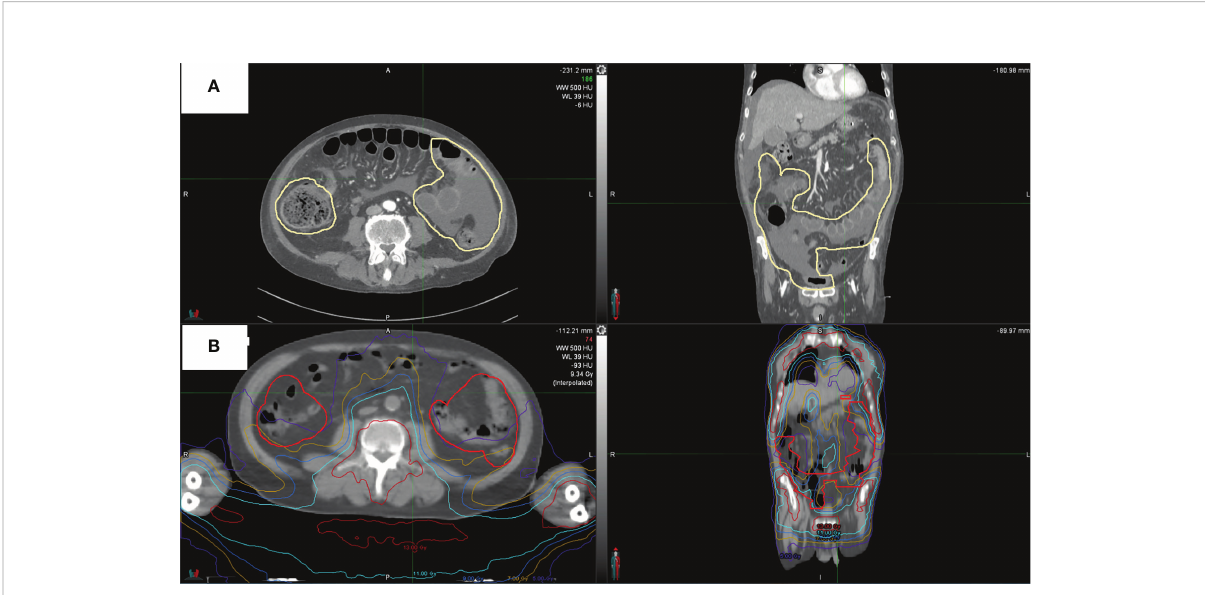
FIGURE 2 CT scan of one representative patient. (A) shows intestinal areas with aGvHD as outlined in pale yellow. (B) shows aGvHD as contoured on this patient ’ s original treatment plan and dose